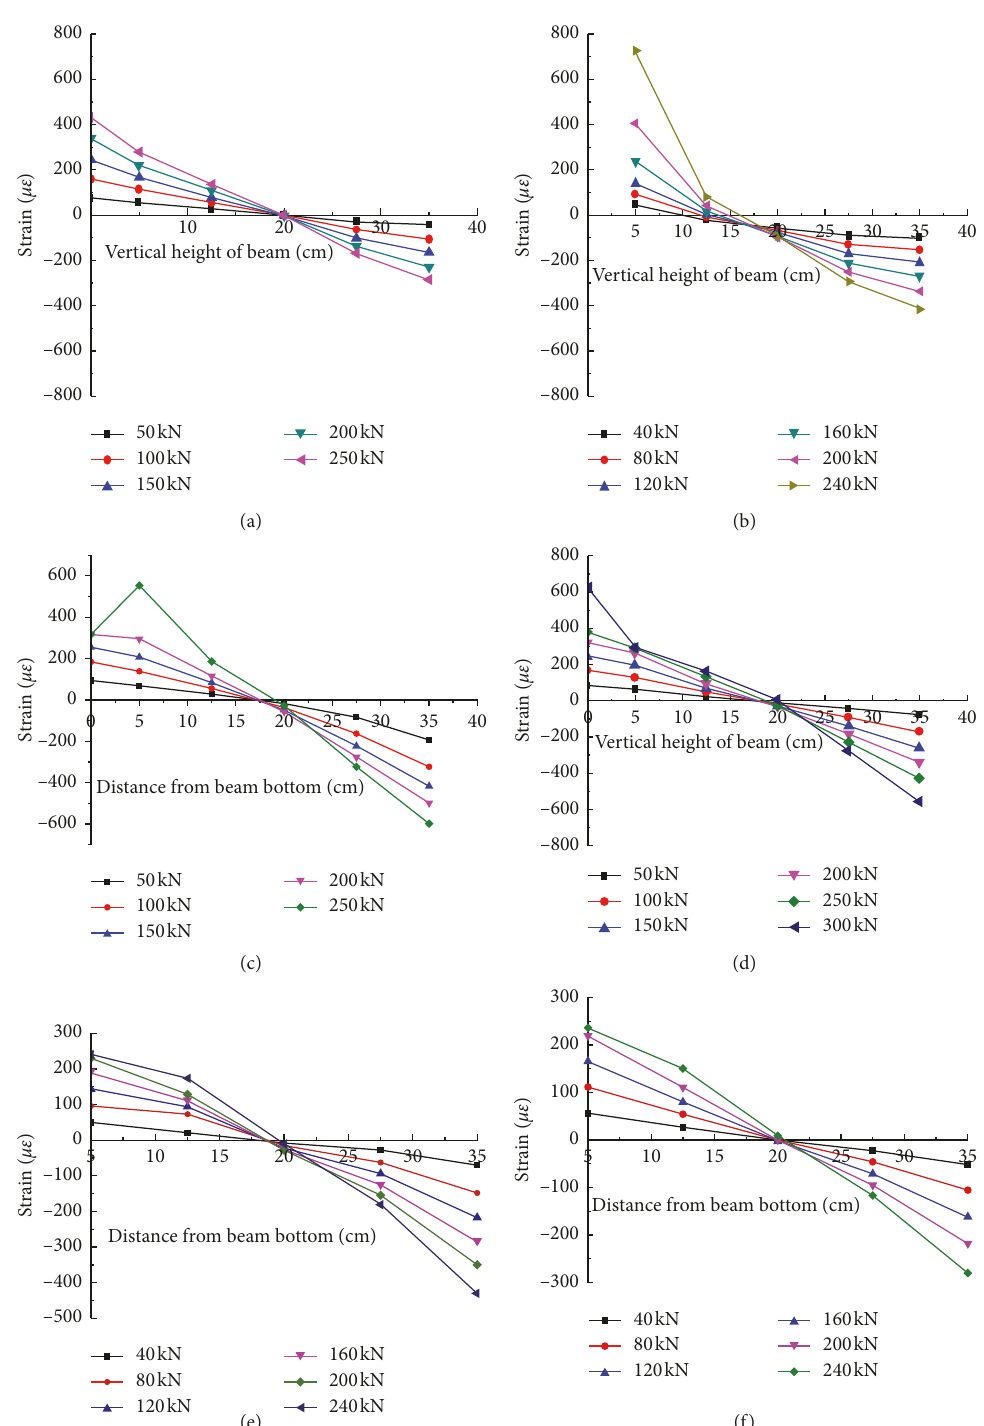
Figure 10: Concrete strain distributions through the girder height at a midspan cross section. (a) PC 1-0-0. (b) PC 2-0-6. (c) PC 3-0-8. (d) PC 4-0-9. (e) PC 5-6-8. (f) PC